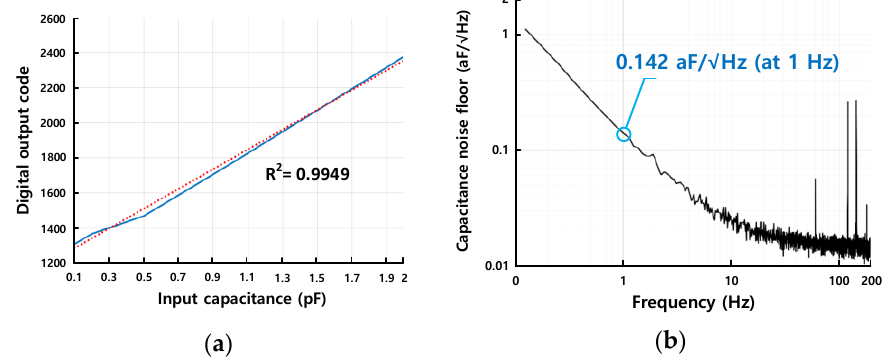
Figure 13. Measured input referred current noise in the current-sensing mode. The gain could be adjusted from 250 mV/pF to 1250 mV/fF. The measured capacitance noise floor at 1 Hz was 0.142 aF/√Hz. The RMS capacitance noise floor was 0.313 aF rms over the bandwidth from 1 Hz to 200 Hz.